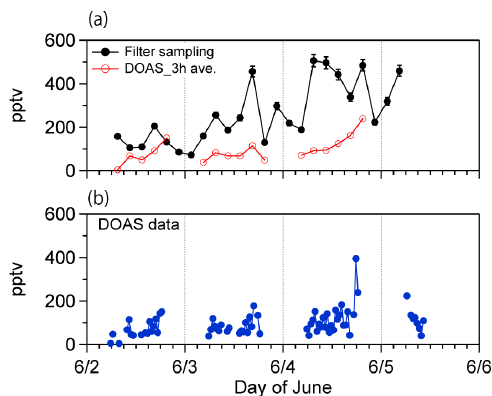
Fig. 7. (a) Mixing ratios of glyoxal (pptv) determined by filter sam- Fig. 8 pling/GC method and MAX-DOAS. The MAX-DOAS data are av- eraged for 3 h intervals. (b) Mixing ratios of glyoxal obtained from MAX-DOAS every 30 min.